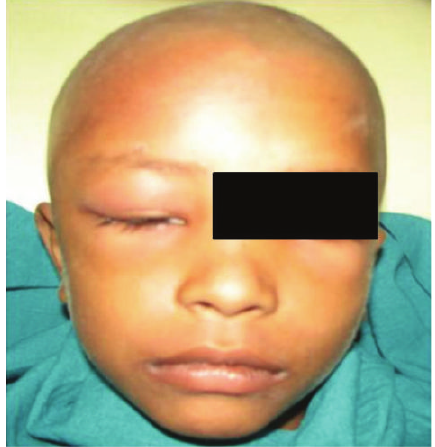
Figure 2: Swelling over the temporoorbital region.